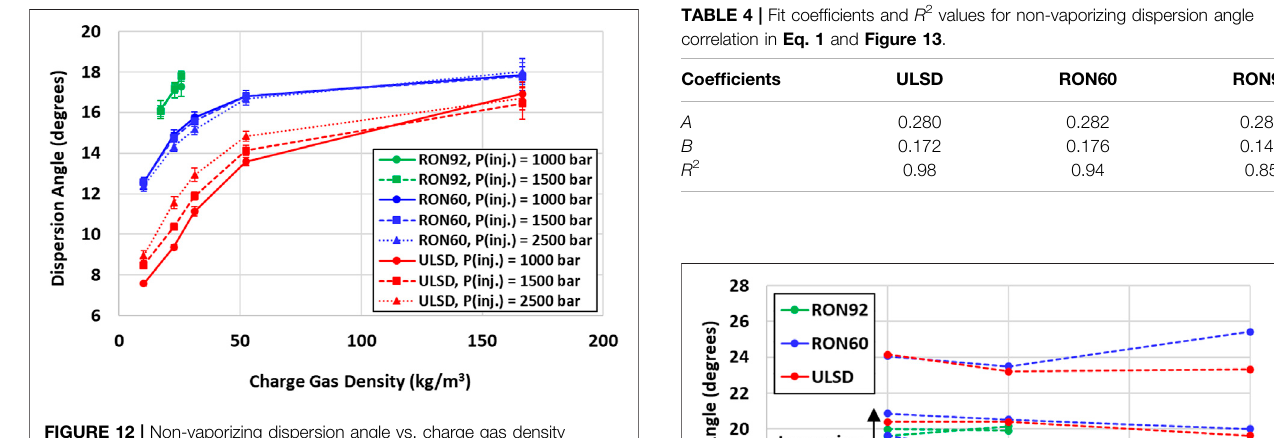
FIGURE 12 | Non-vaporizing dispersion angle vs. charge gas density using 45d o criterion.